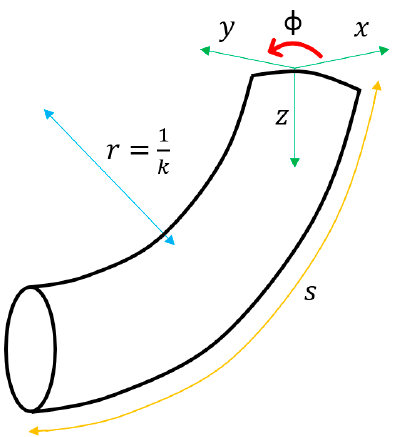
Figure 2. Kinematic model using the PCC method. Adapted from [10].